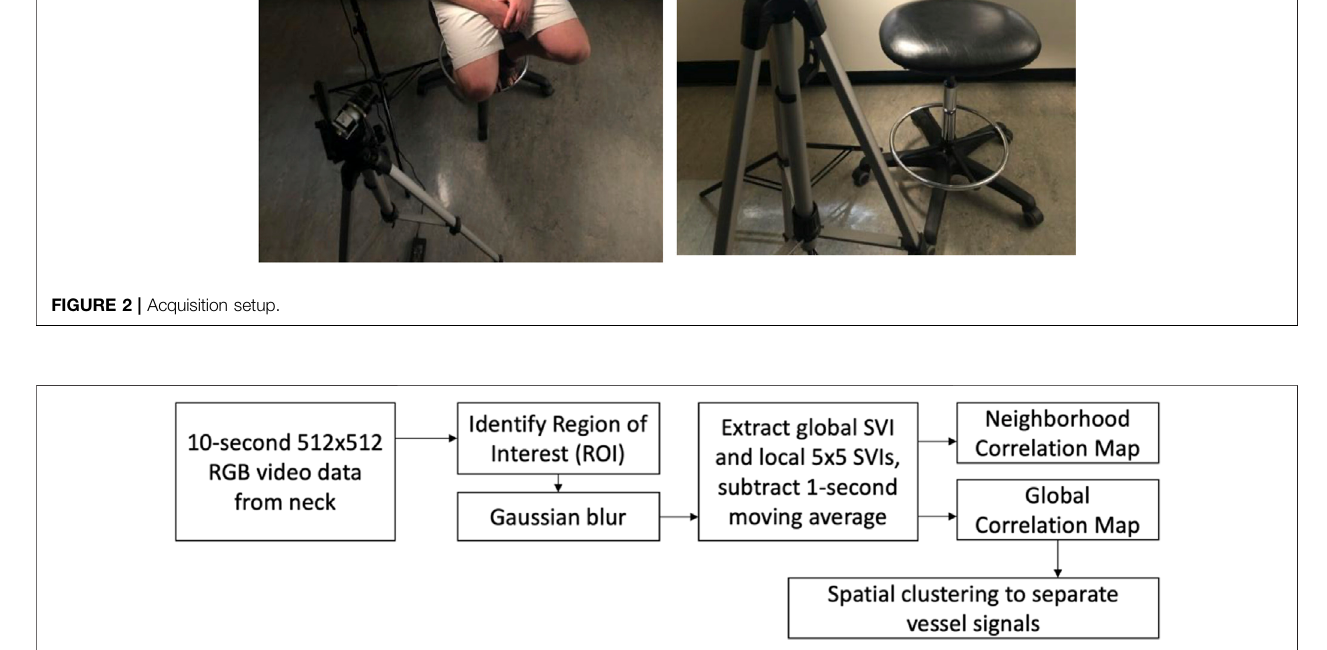
FIGURE 3 | Image processing fl